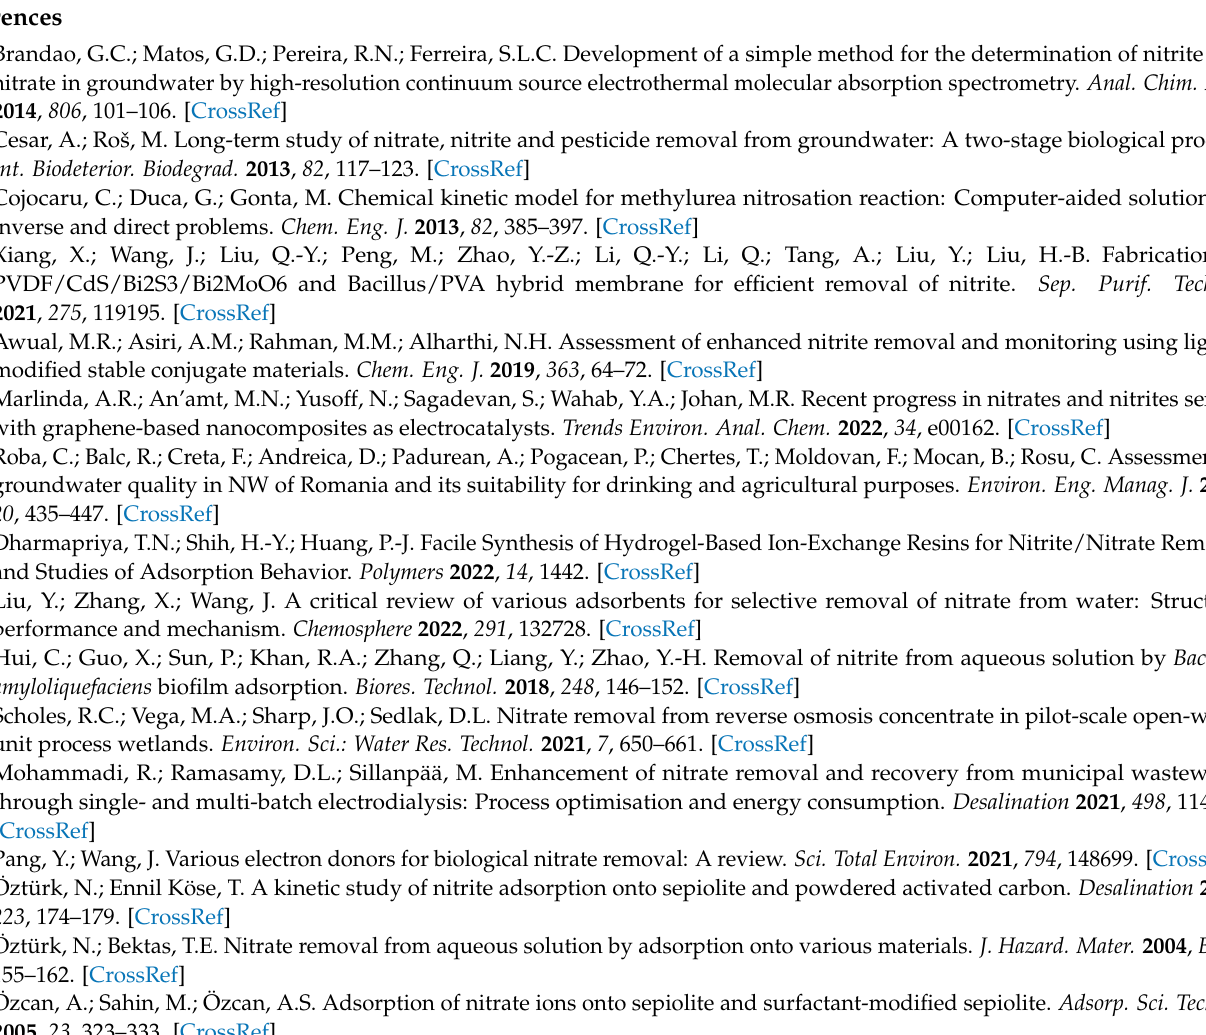
Table S8: ANOVA-Analysis of Variance (ANOVA) of the SVM-model